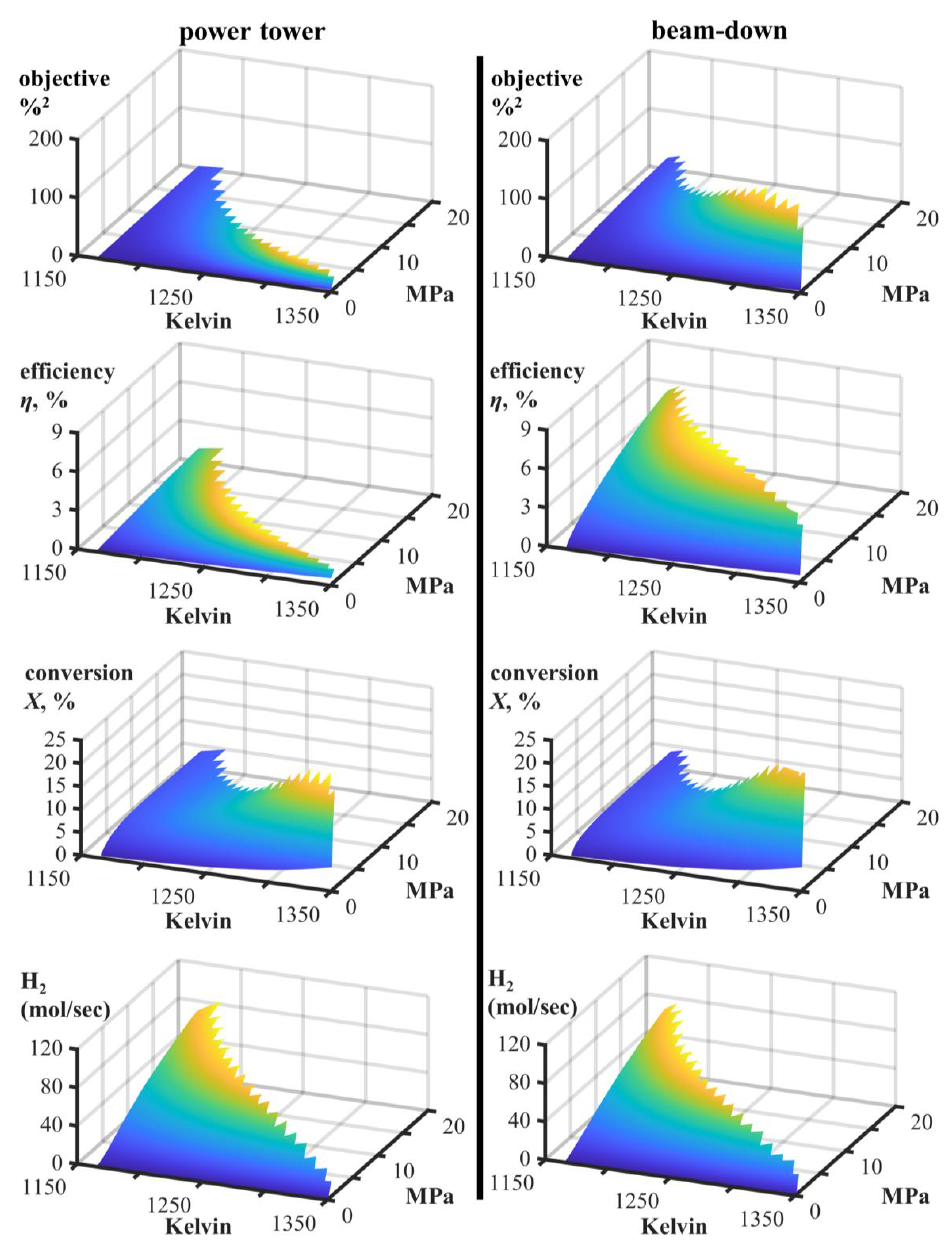
Figure 6. Performance metrics of alternative solar facilities for H 2 production.